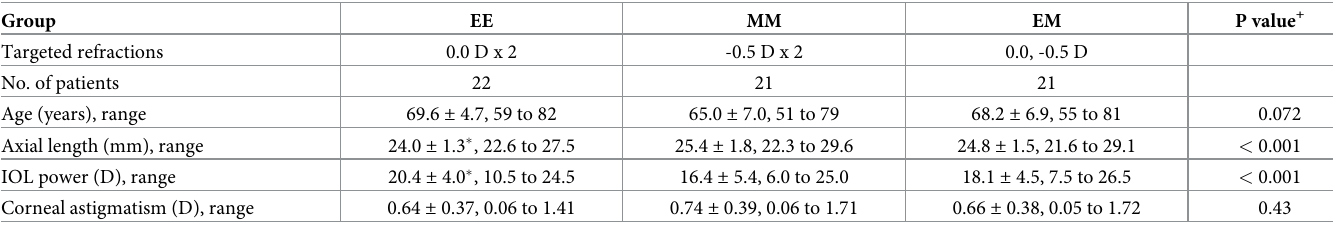
Table 1. Preoperative demographic